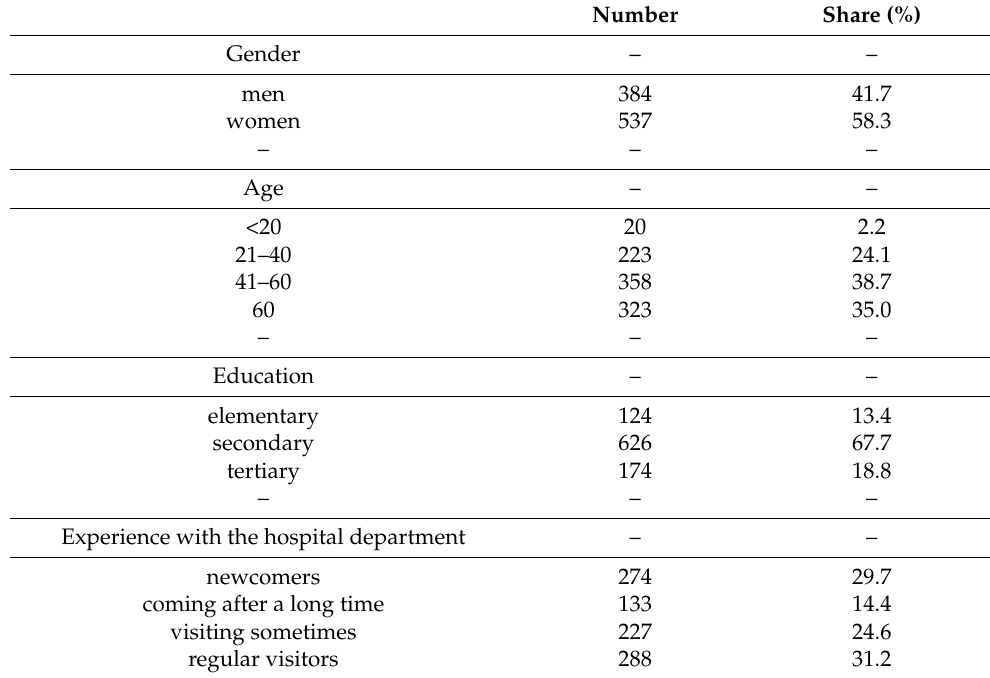
Table 2. Structure of the respondents: descriptive